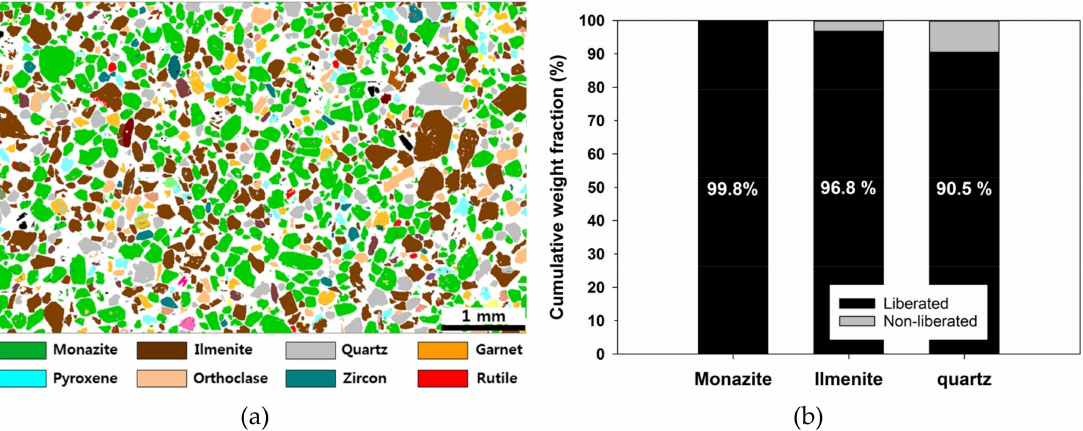
Figure 3. The part of polished section image ( a ) of feed sample analyzed by mineral liberation analysis (MLA) and degree of liberation ( b ) of main minerals in the feed sample.